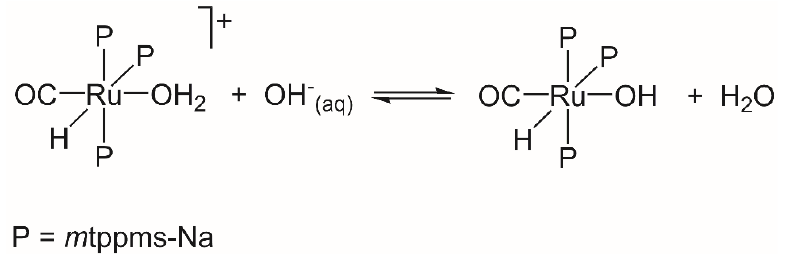
+ 2 O in [RuH(H 2 O)(CO)( m tppms-Na) 3 ]